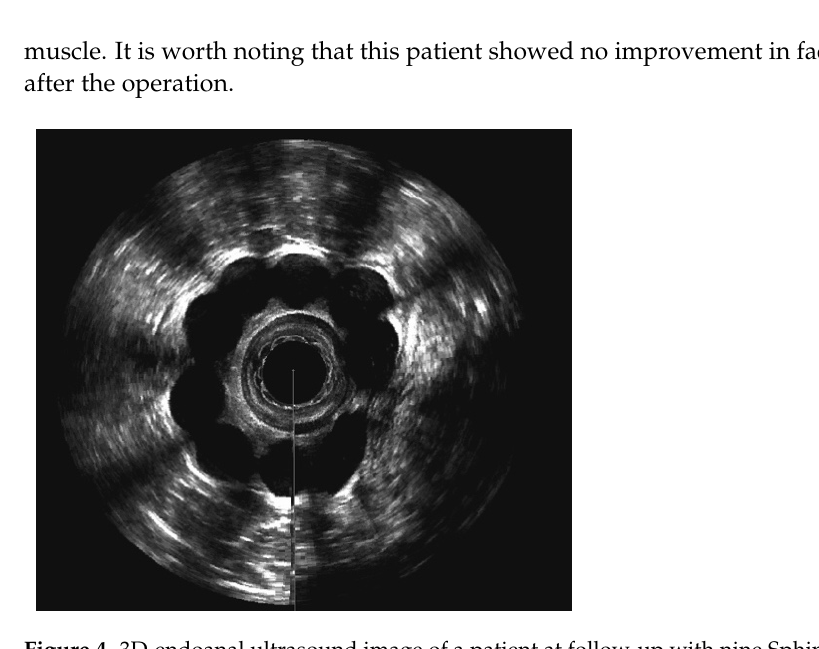
Figure 5. 3D-endoanal ultrasound image: A migrated prosthesis in a 56.4° angle to the anal canal.